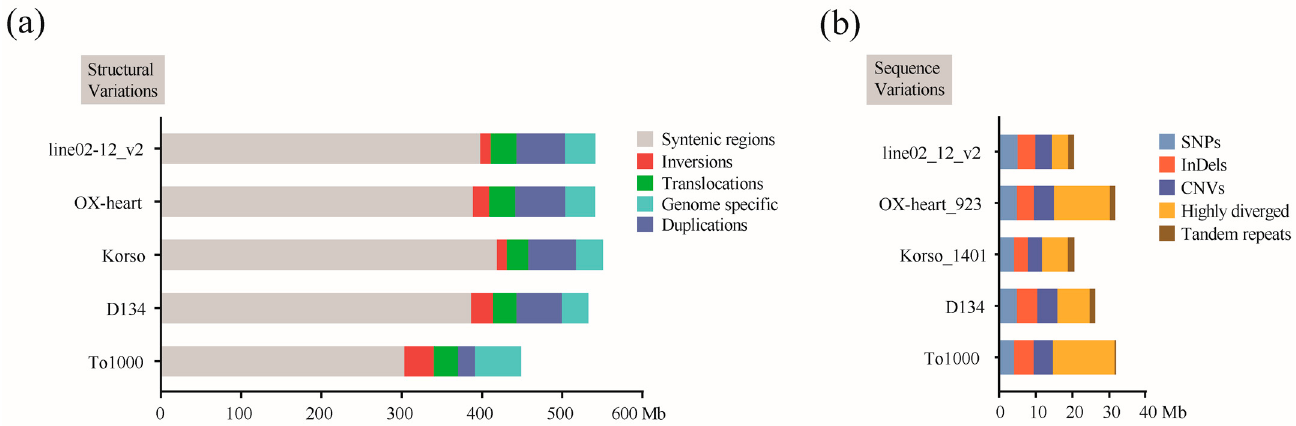
Figure 4. Structural and sequence variations between seven B. oleracea genomes. The bar plots show the total span of syntenic and structural variational ( a ) and sequence variational ( b ) regions between the HDEM and each of the other accessions.